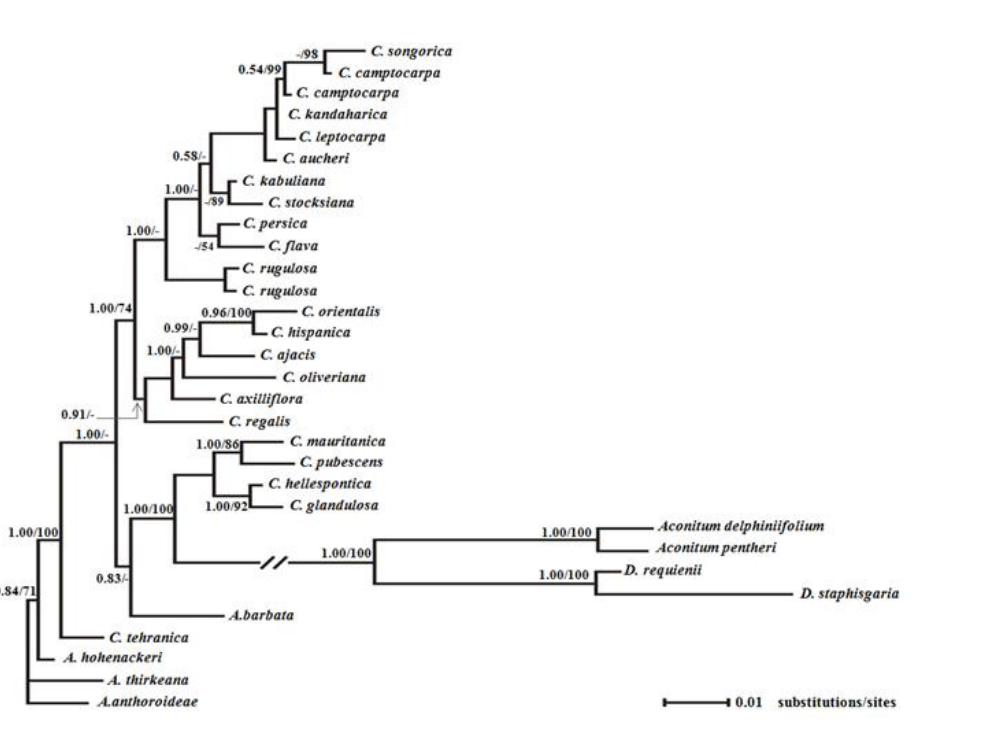
Fig. 3. Majority- rule (50%) consensus tree resulting from Bayesian analysis of the combined data set (trnL-F and nr DNA ITS) in Consolida species. Support values are indicated above the branches (Bayesian posterior probabilities (PP) and maximum parsimony bootstrap (MP), respectively). Values < 50% not shown.